Question: Condense the content of this figure into a single sentence.
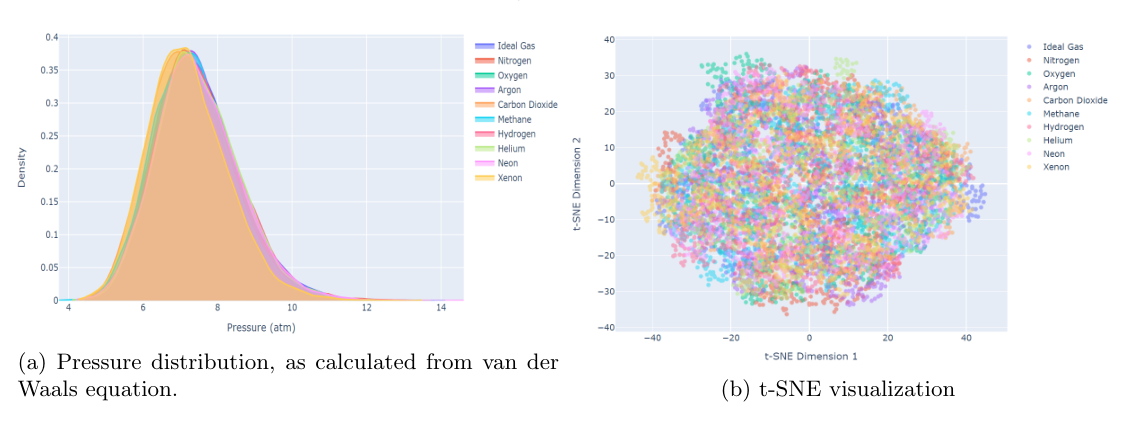
Answer: Pressure distribution and t-SNE plot for the various gases